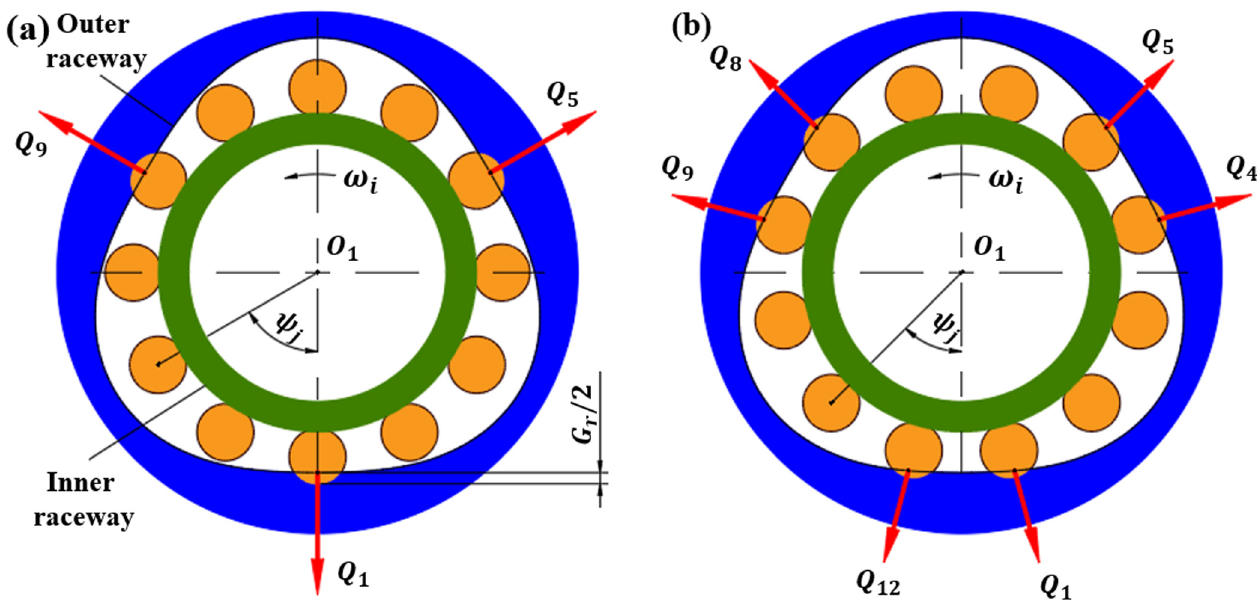
Fig. 2. Preload distribution of the cylindrical roller bearing with triple-lobe raceway before loading: (a) single-pressed state; (b) double-pressed